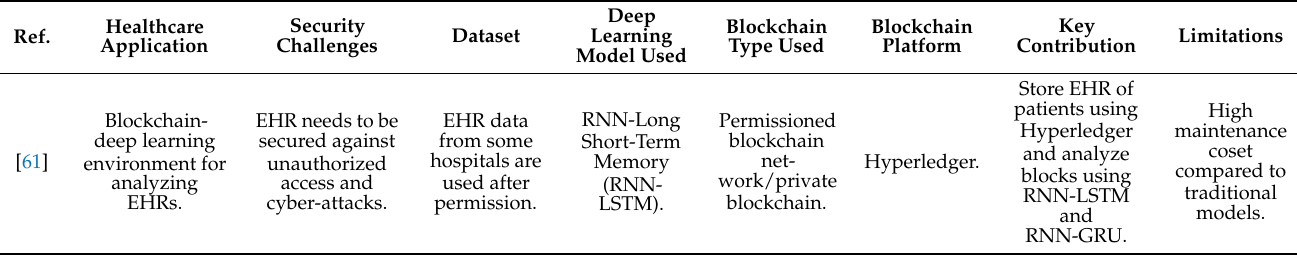
Table 4. A summary of works on deep learning-enabled Blockchain Technologies for Public Health.